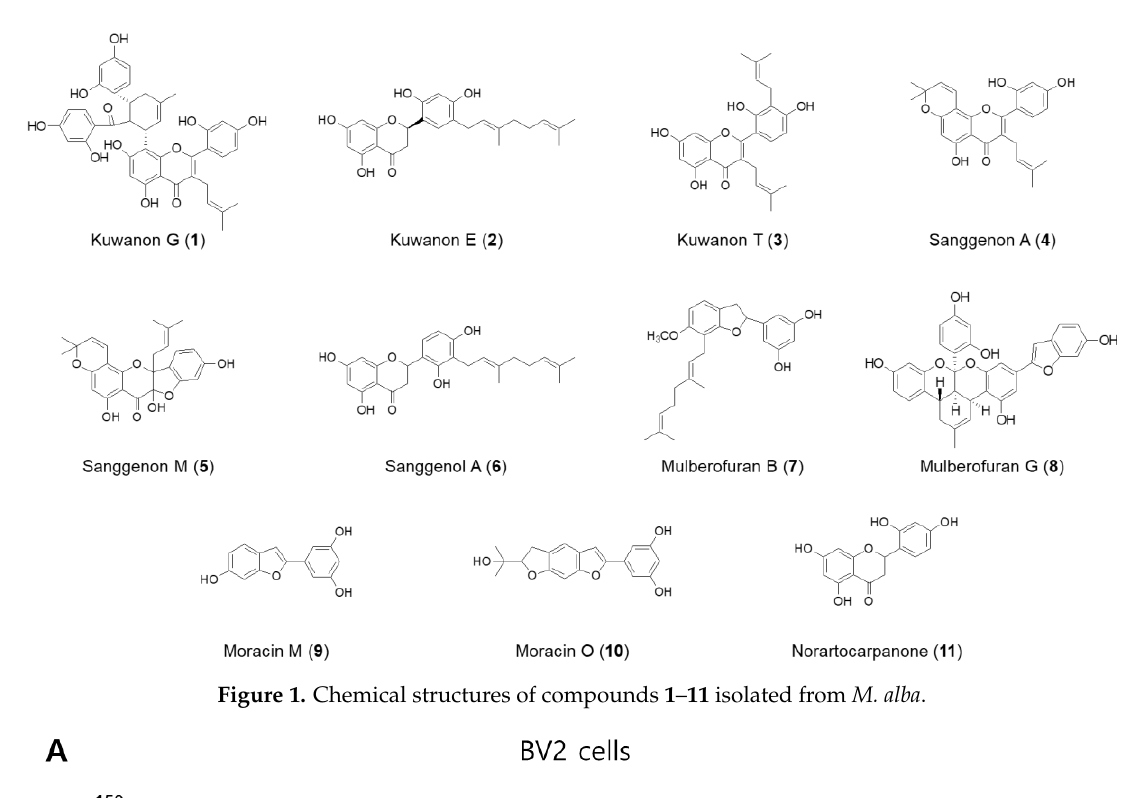
Figure 1. Chemical structures of compounds 1 – 11 isolated from M. alba.